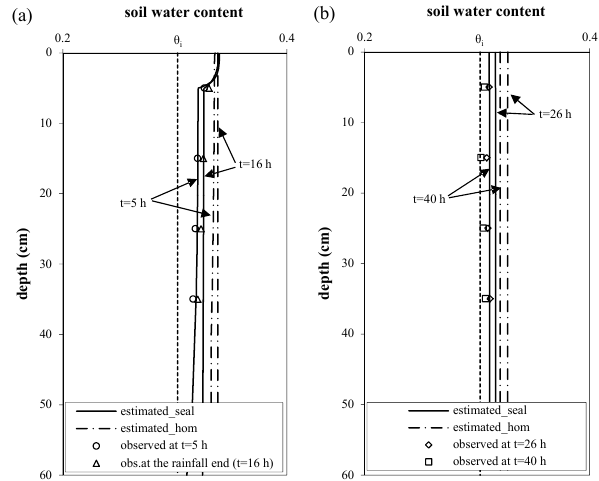
Fig. 8. Water content profiles simulated by the adopted models for homogeneous soil and sealed soil and specific values observed at different depths during (a) the infiltration stage, (b) the redistribution stage. Event 6 of Fig. 2 (see also Table 2). Saturated hydraulic conductivity of the parent soil 2 mmh -1 and seal layer 0.12 mmh -1 .